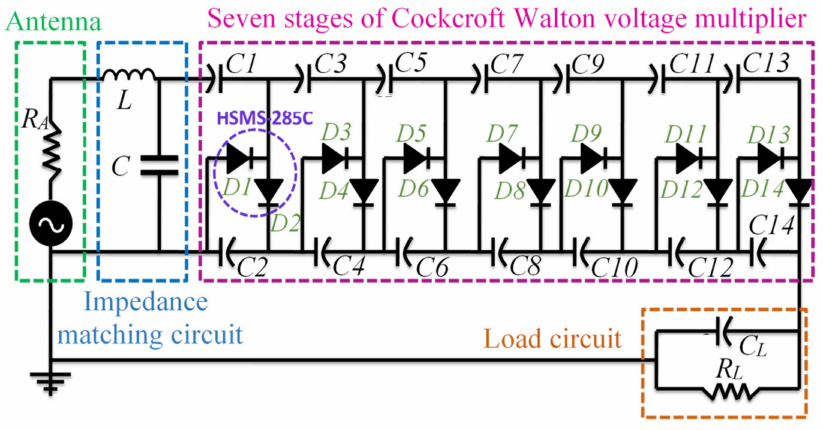
Figure 6. Rectenna design parameters in Cockcroft–Walton voltage multiplier circuit.